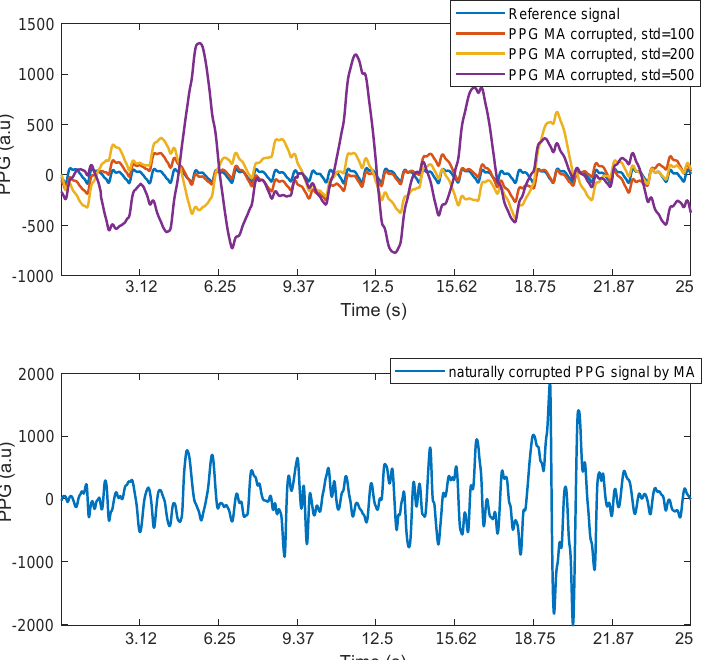
Figure 8. ( Top ) Reference PPG and PPG corrupted by noise using the synthetic noise generator at three different intensity levels ( σ = 100, 200, and 500, T = 500, and stride = 100). ( Bottom ) PPG signal naturally corrupted by noise during physical